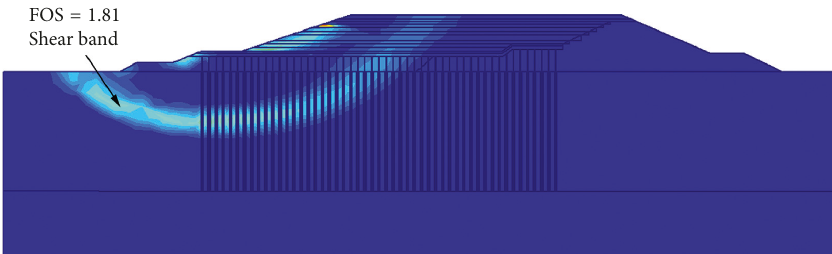
Figure 10: Predicted critical slip surface and factor of safety of the